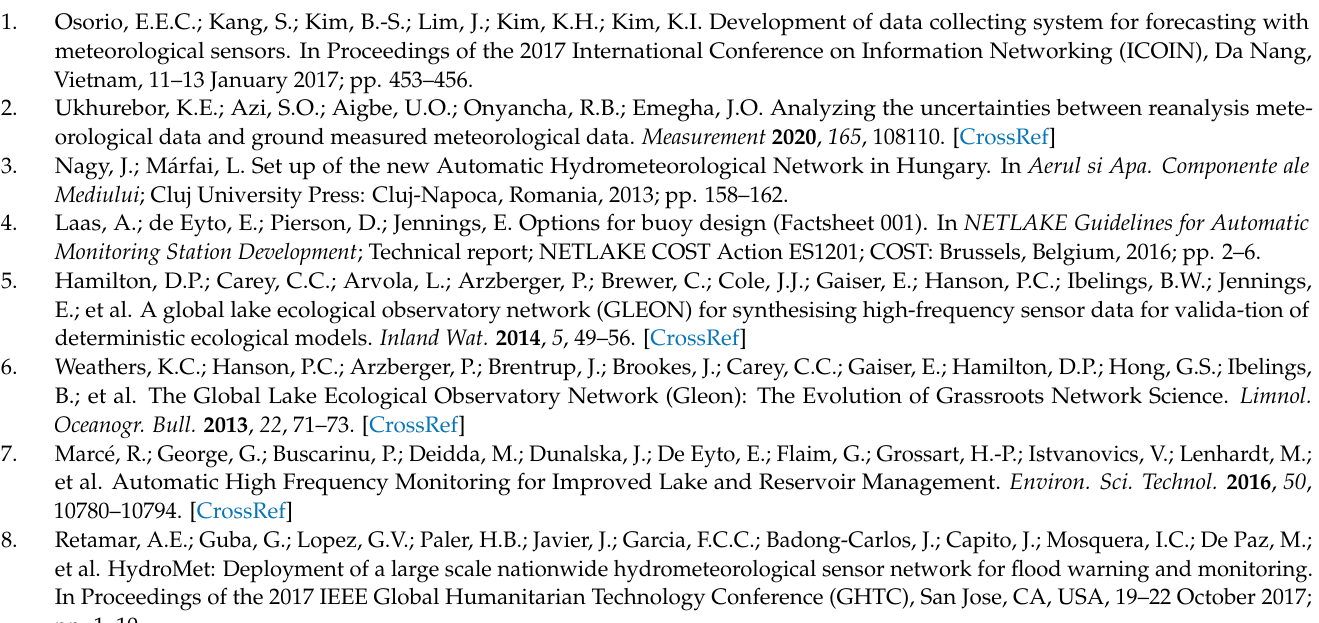
and analogue inputs board, Figure S2: Photograph of the board and diagram of 1 Wire for pluviometer, Figure S3: Diagram of RS485 standard, Figure S4: Scheme of power supply elements